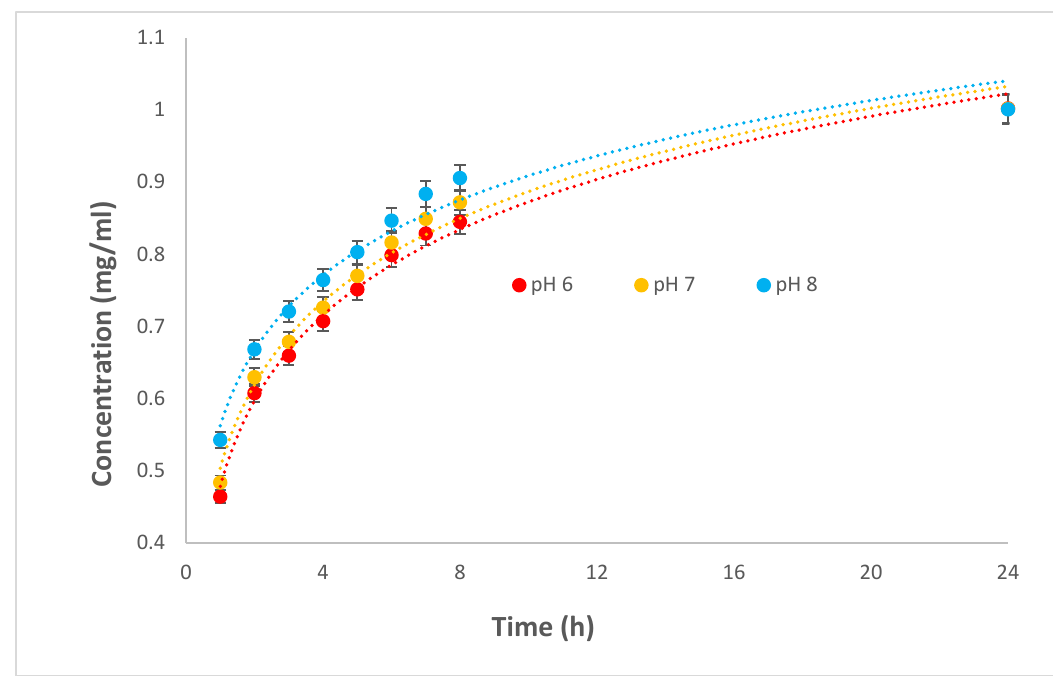
Figure 7. Amoxicillin drug release for BC-PAA composites in different pH values.